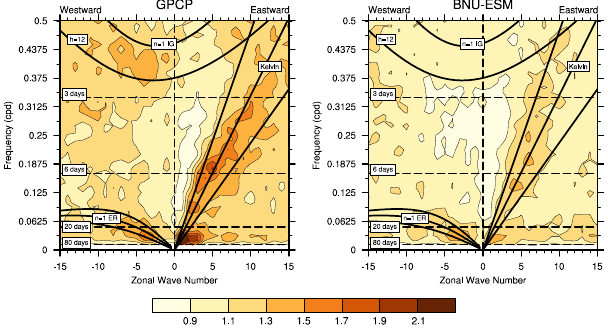
Figure 16. Space–time spectrum of the 15 ◦ N–15 ◦ S symmetric component of precipitation divided by the background spectrum. Superimposed are the dispersion curves of the odd meridional mode numbered equatorial waves for 12, 25, and 50m equivalent depths. Frequency spectral width is 1 / 128cpd.